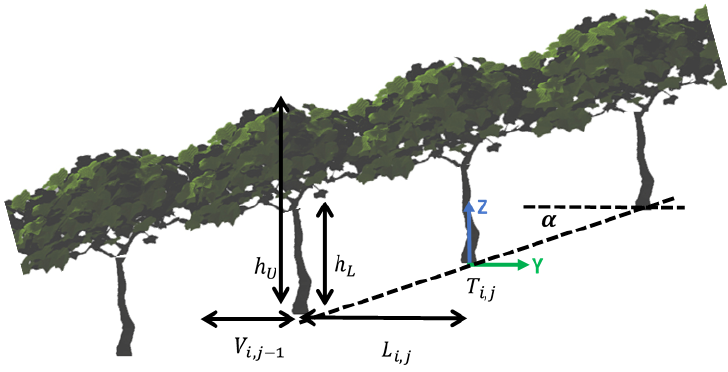
Figure 8. The example of the elevation model of a vineyard planted on a sloping